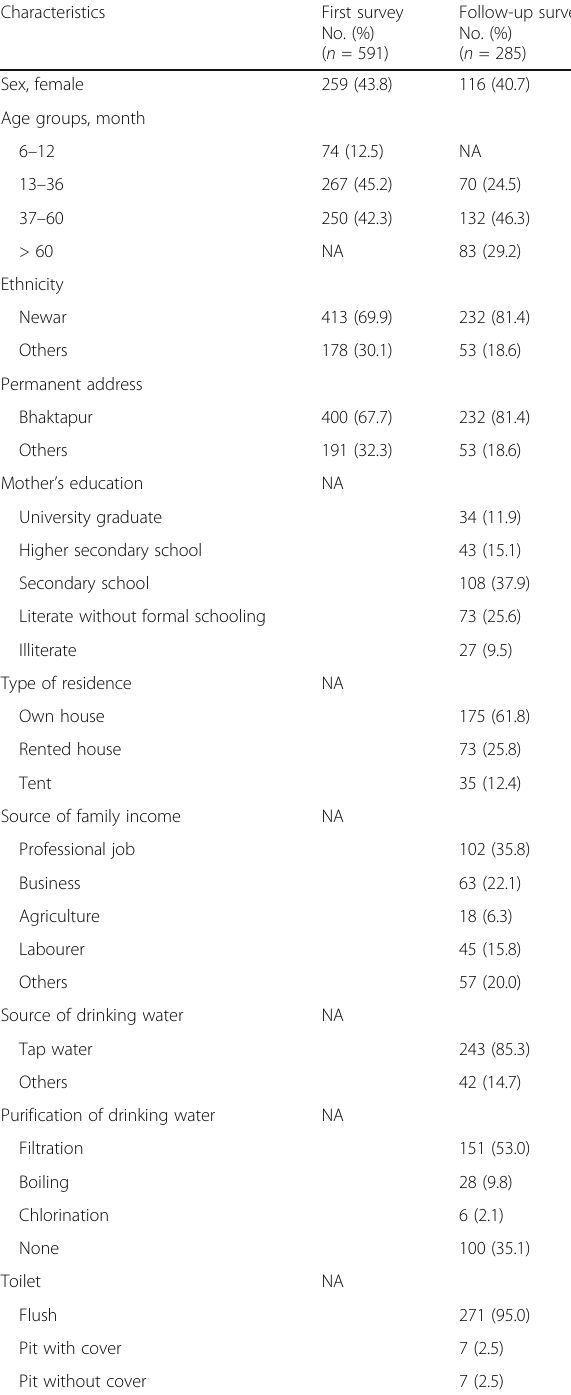
Table 1 Characteristics of children in the first and the follow-up surveys